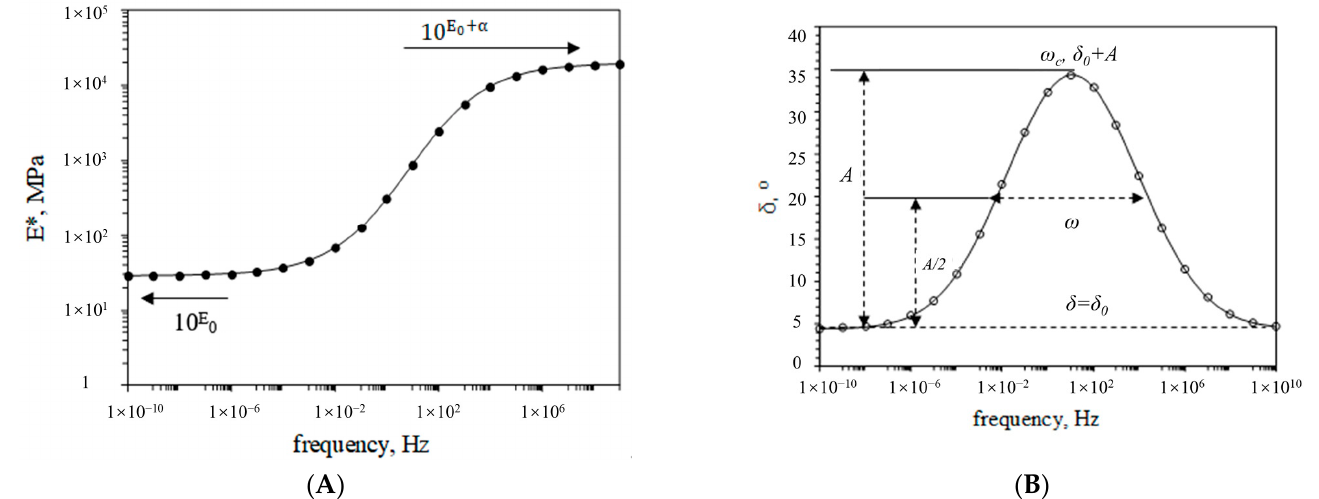
Figure 1. Example of master curves of the asphalt mixture. ( A ) Dynamic modulus master curve, ( B ) Phase angle master curve.